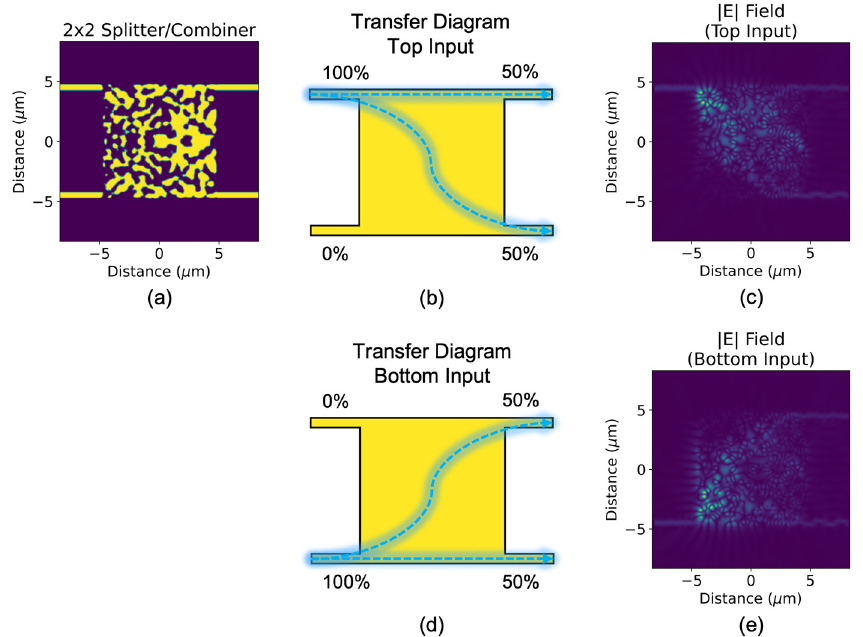
Figure 1. ( a ) Topologically optimized 2 × 2 3-dB splitter/combiner (in splitter mode) and its transfer diagrams for the following initial conditions: ( b ) input at the top waveguide, ( d ) input at the bottom waveguide. Top-view optical field profiles of ( b , d ) are shown in ( c , e ), respectively.